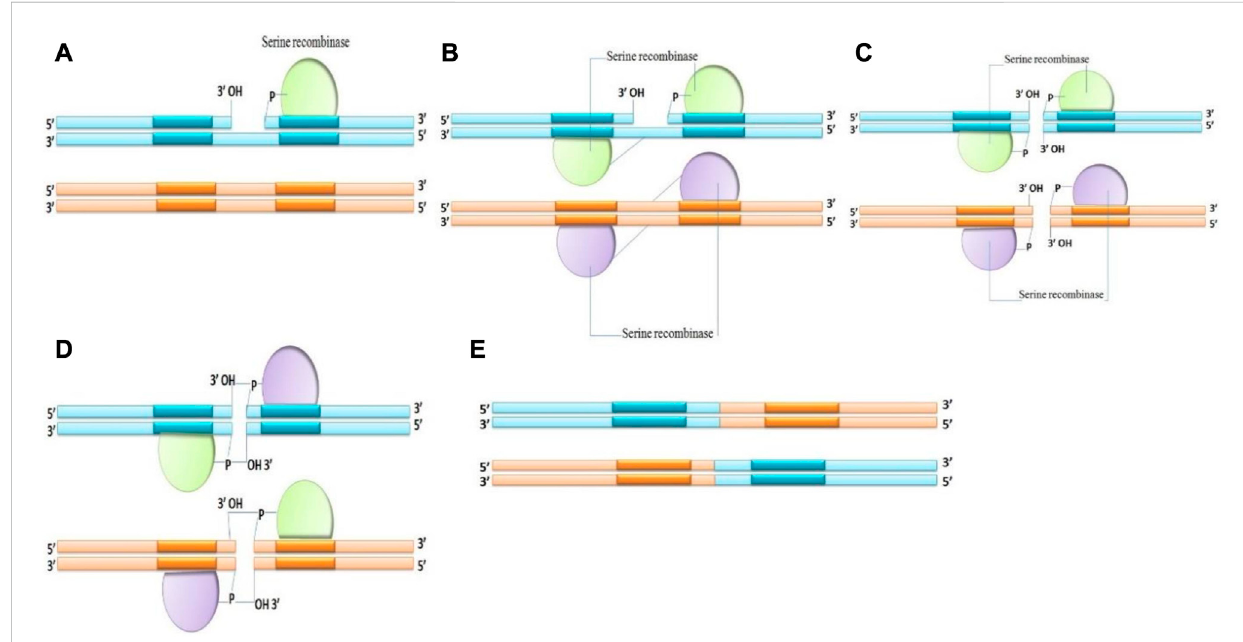
FIGURE 3 Mechanism of Serine recombinase (A – E) making double-strand breaks in all crossover sites before reshuf fl ing the fragmented DNA ends and rejoining the